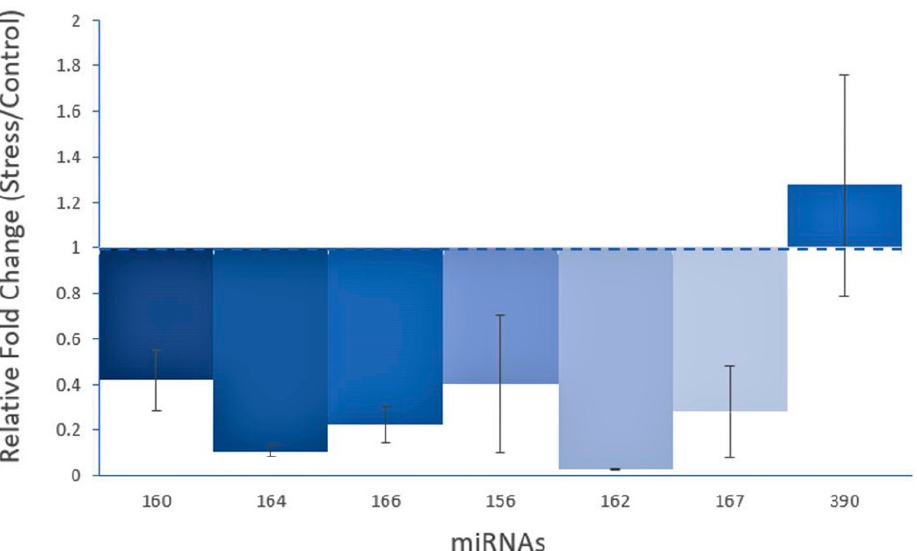
Figure 10. Evaluation of relative fold change of the selected guava miRNAs under salinity stress. The delta-delta CT method was used to determine the fold change and the U6 RNA was used as a normalization control. The values were further normalized with respect to the control condition that was set to 1.